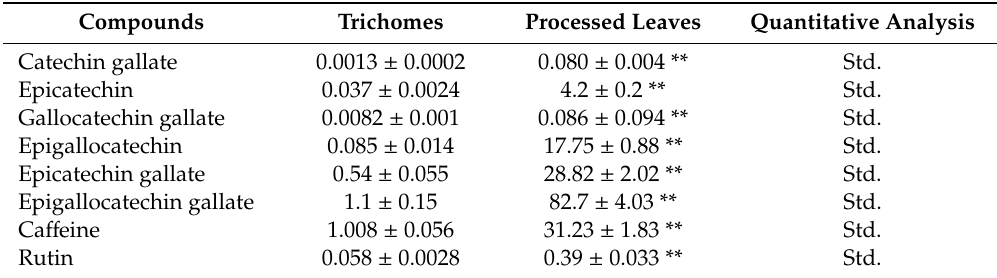
Table 2. Contents of the main catechins, ca ff eine, and rutin in trichomes and processed leaves (mg / g dry